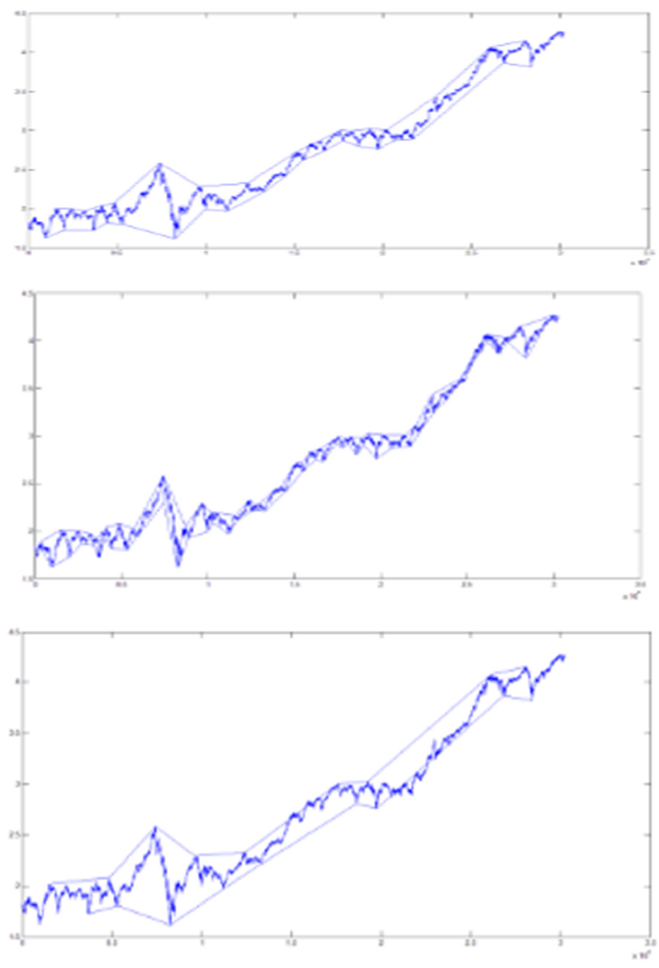
Figure 8. Maximum and minimum determined by the Rolling Windows method. Source: Authors’ processing is based on graphics generated in Matlab for 200 ‐ , 500 ‐ , and 1000 ‐ day windows using data available on http://stooq.com/ (accessed on 20 July 2017). available on http://stooq.com/ (accessed on 20 July